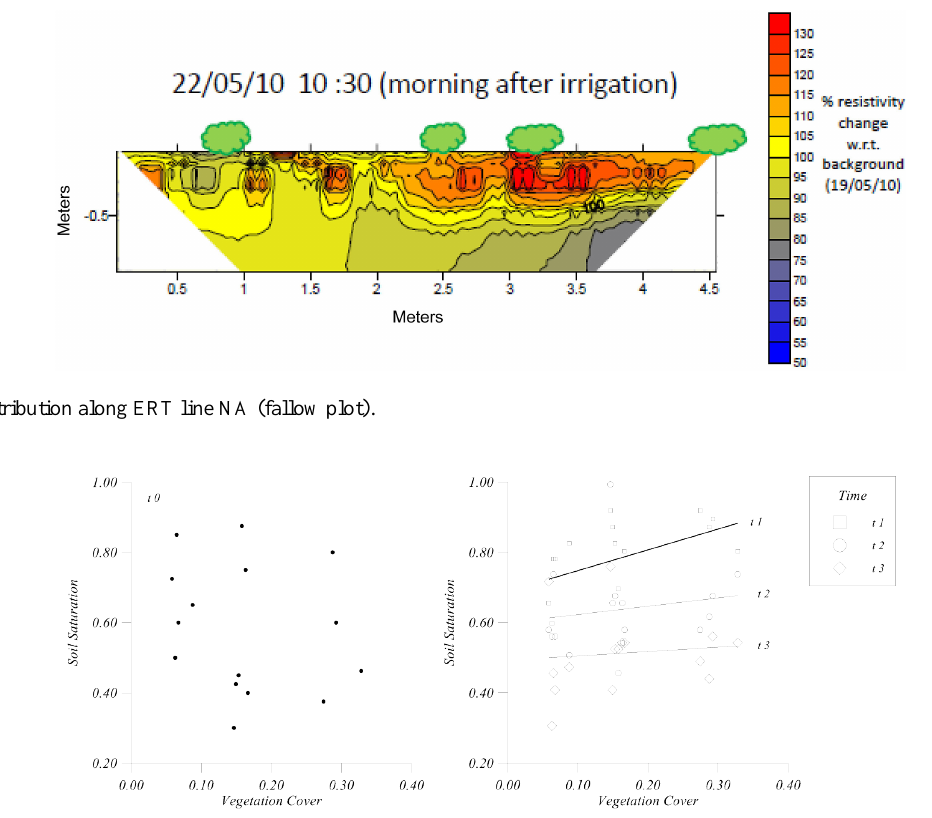
Fig. 9. Left panel: vegetation cover (CC) versus soil saturation after rainfall. Soil saturation is measured by portable TDR (rod length 21cm). t 0 : 21 May, 10:30LT – (bold circles). Right panel: vegetation cover versus soil saturation at different times after irrigation. Soil saturation is measured by TDR (rod length=32cm). t 1 : 22 May, 11:30LT (squares); t 2 : 23 May, 09:30LT (open circles); t 3 : 24 May, 10:30LT